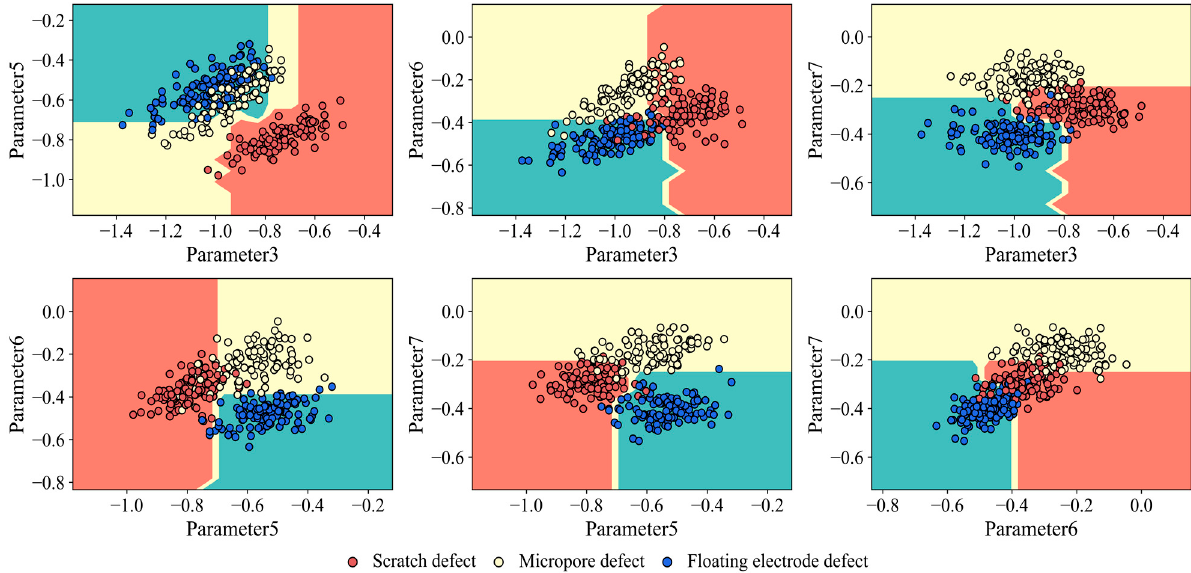
Figure 10. Decision region of the simplified PD recognition model.